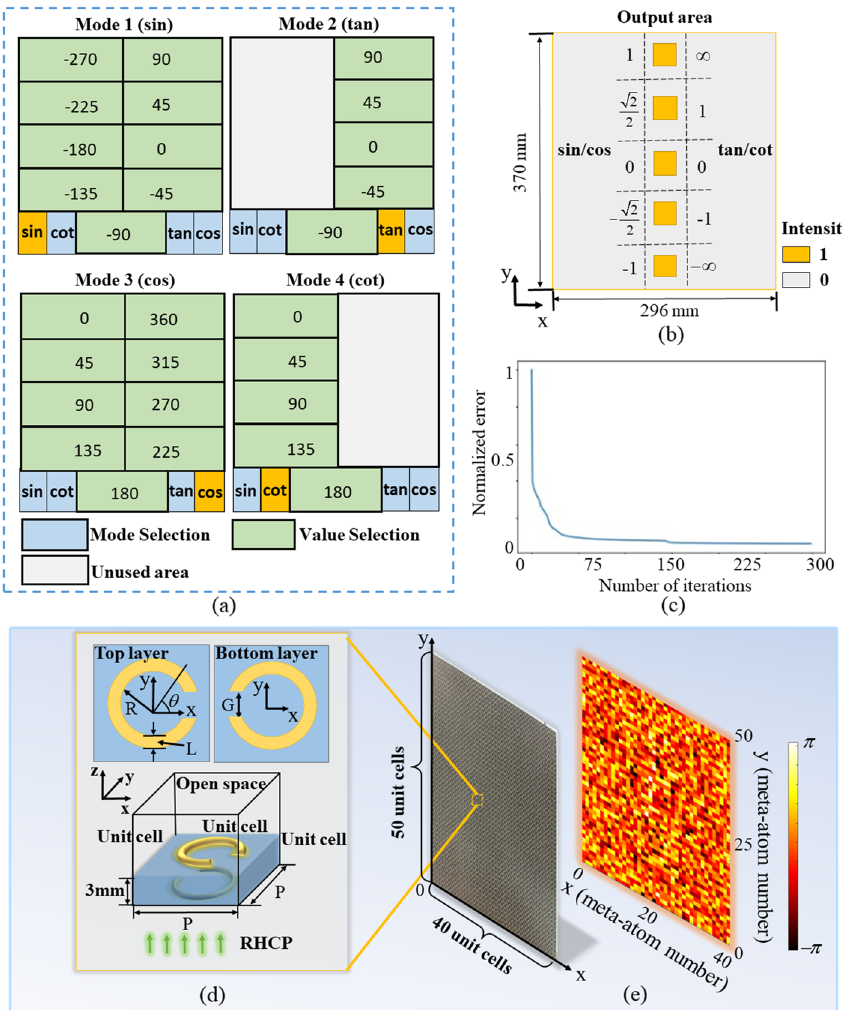
Fig. 2 Designed input and output modes and training results of the diffractive neural networks and the proposed metasurface structure for mapping the hidden layer. (a) Designed target output image utilized for training the network. (b) All designed types of outputs corresponding to four trigonometric operation modes in this work. (c) Normalized error between the obtained and ideal results during the iteration of the designed diffractive neural network. (d) Schematic diagram of the unit cell of the proposed metasurface with corresponding simulation settings. (e) Photograph of the fabricated metasurface and phase map of the optimized metasurface-based optical trigonometric